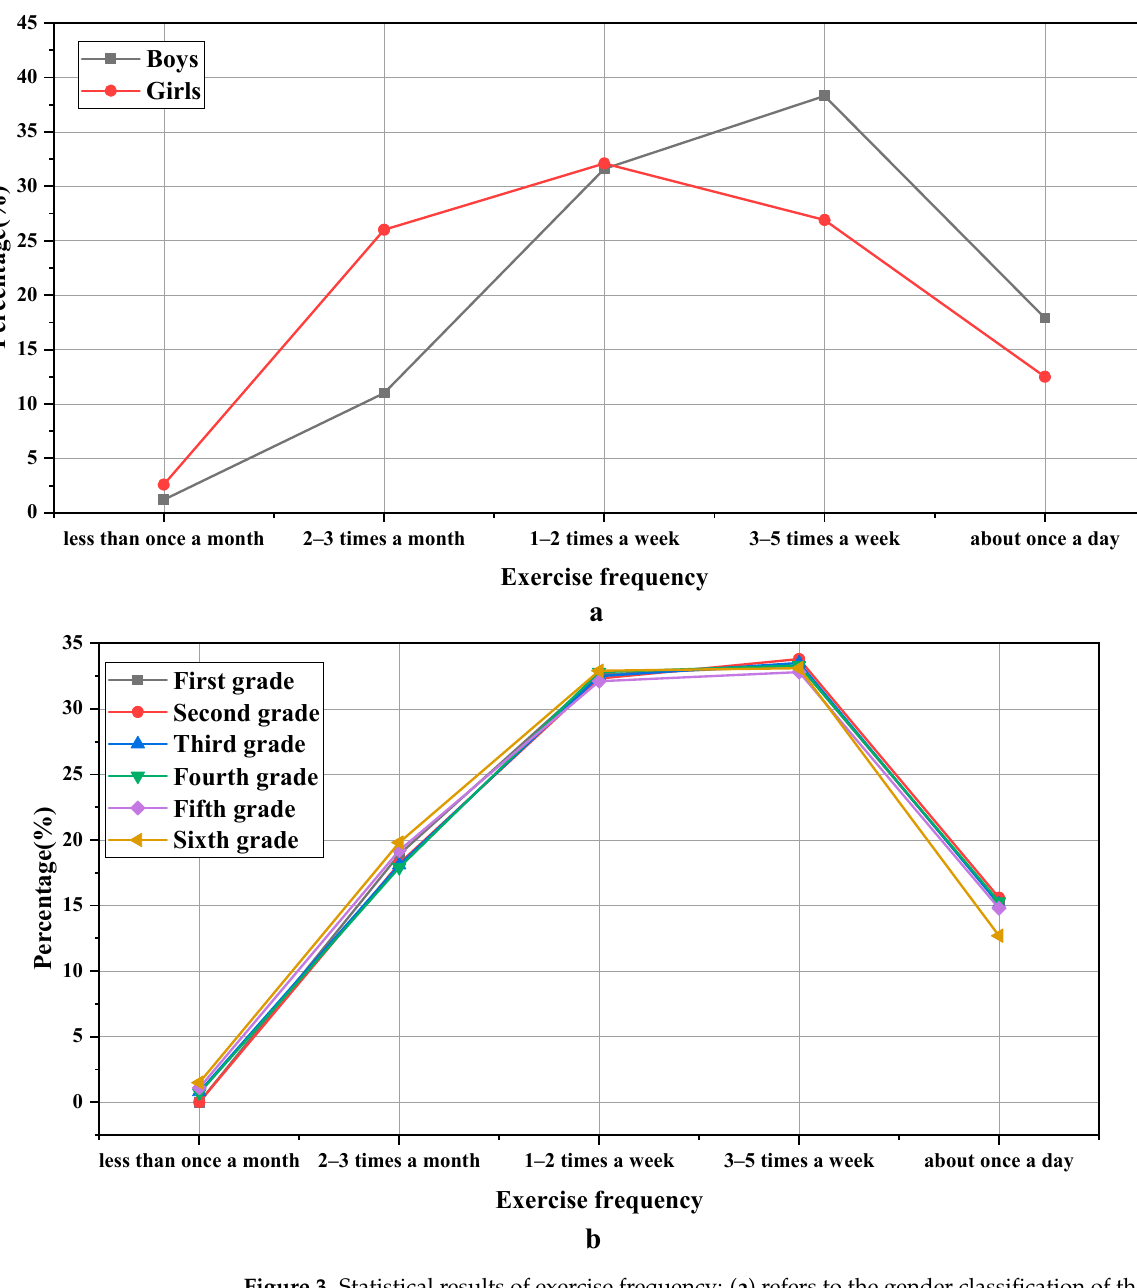
Figure 3. Statistical results of exercise frequency: ( a ) refers to the gender classification of the sample; ( b ) refers to the grade classification of the sample.